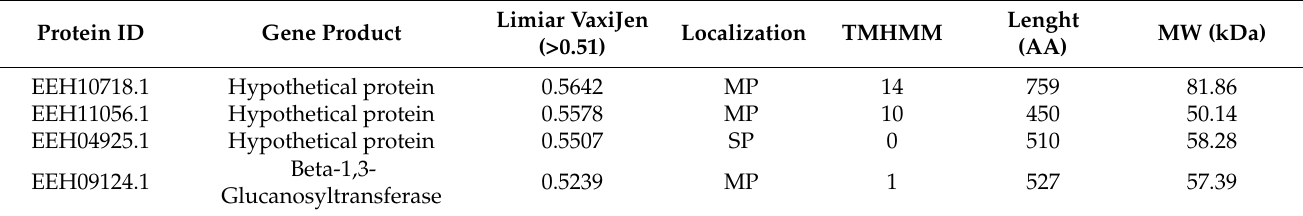
Table 3. Predicted vaccine candidates for Histoplasma capsulatum . VaxiJen predicted the number of transmembrane helices (TMHMM). The subcellular location was obtained from PSORT (MP- membrane protein; PS-secreted protein). The protein name, molecular weight (MW) and amino acids length (AA) were obtained from the Uniprot